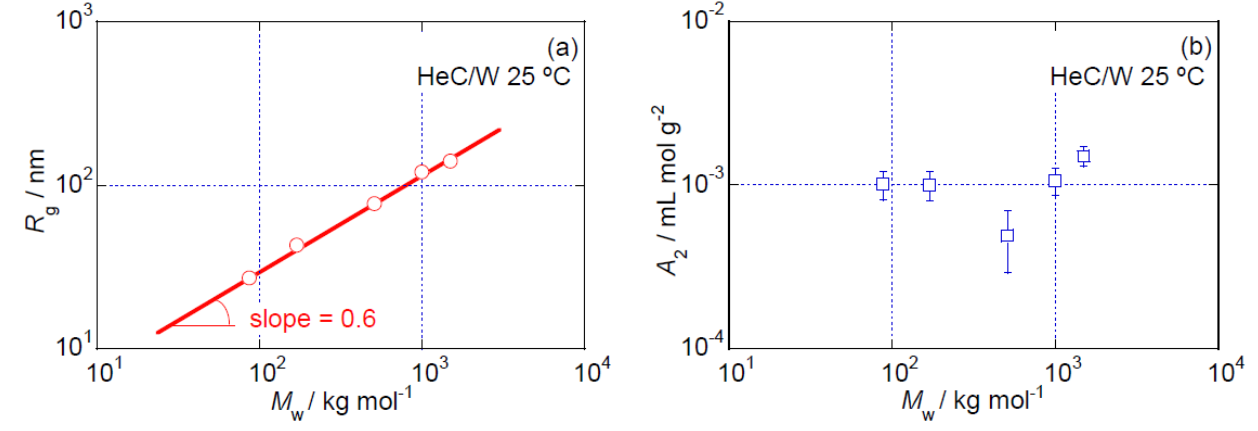
Figure 2. M w dependencies of R g ( a ) and A 2 ( b ) for HeC samples in aqueous solution at 25 °C.